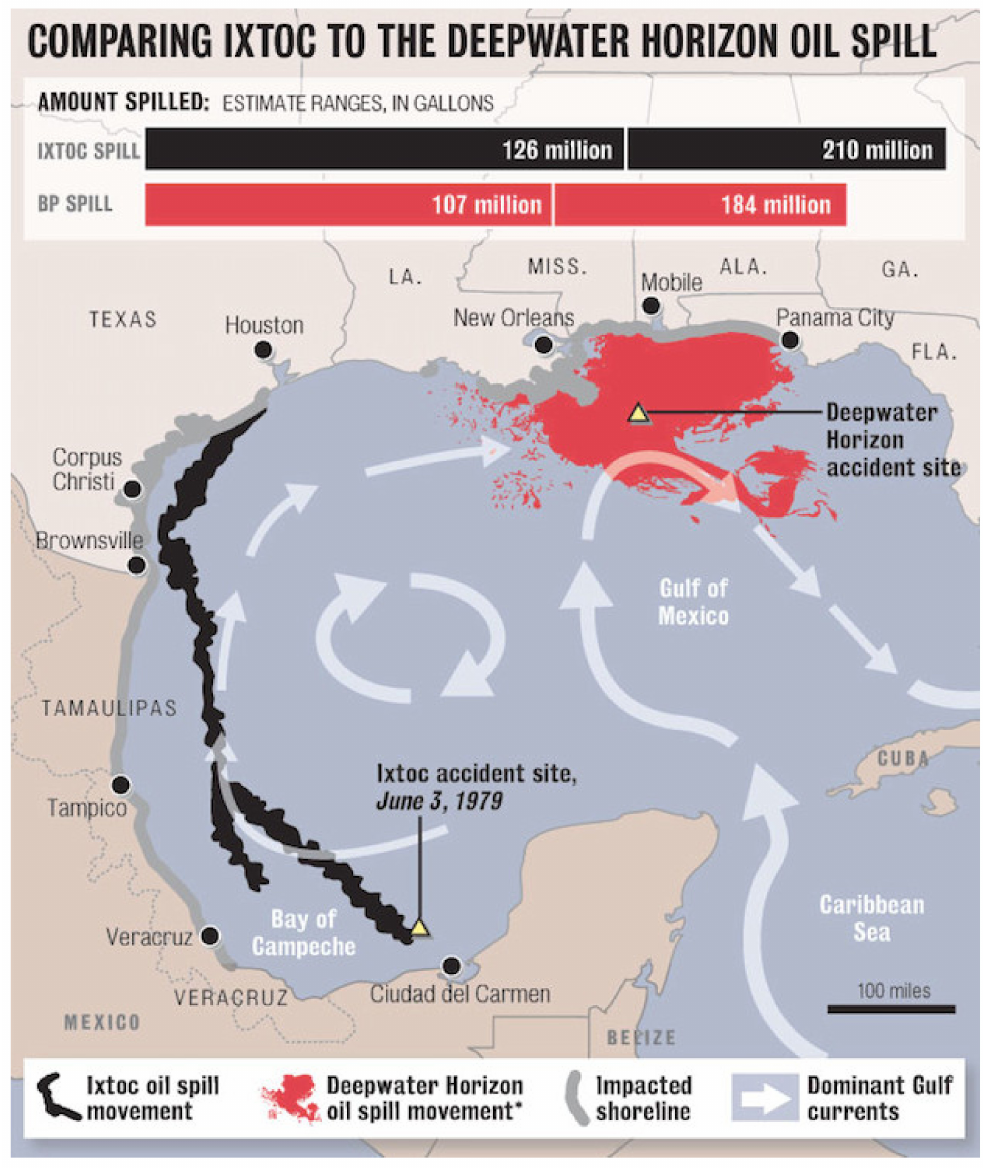
Figure 7. A map of the Ixtoc I oil spill. As the map was published in 2010, measurements and affected locations for the Deepwater Horizon oil spill are inaccurate (Source: National Oceanic and Atmospheric Administration (NOAA) and Unified Command, www.noaa.gov (accessed on 23 December